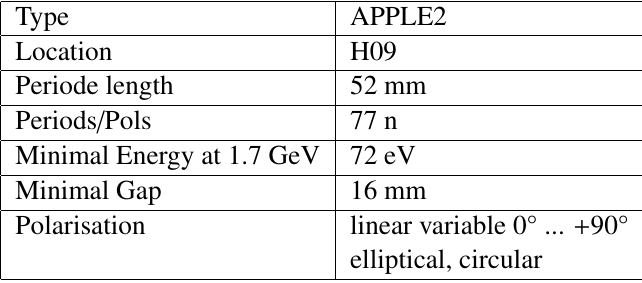
Table 1: Parameters of insertion device